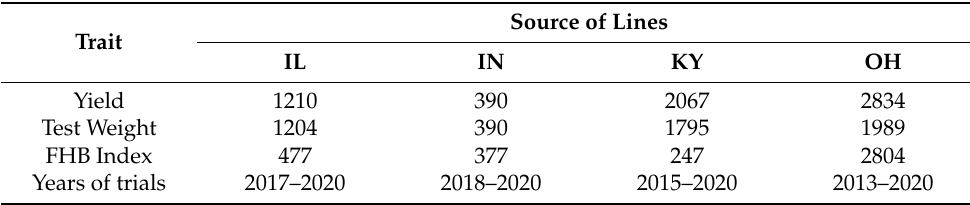
Table 1. Number of lines used as training population for genomic predictions and cross-validation for each trait collected from the stage-gate trails of each breeding programs.